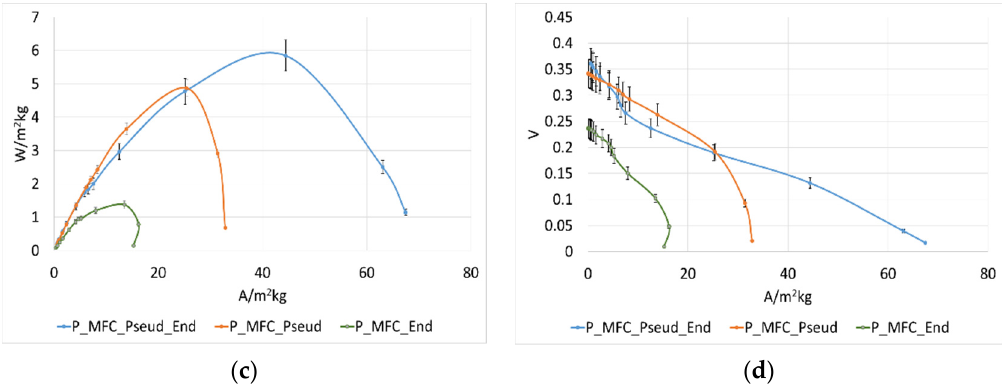
Figure 9. Power and polarization curves in B_MFCs ( a , b ) and P_MFCs ( c , d ) in the presence of P.aeruginosa + endogenous microflora (End_Pseud); P.aeruginosa (Pseud) and endogenous microflora (End). The diagrams report the average values ± SE over three independent experiments.